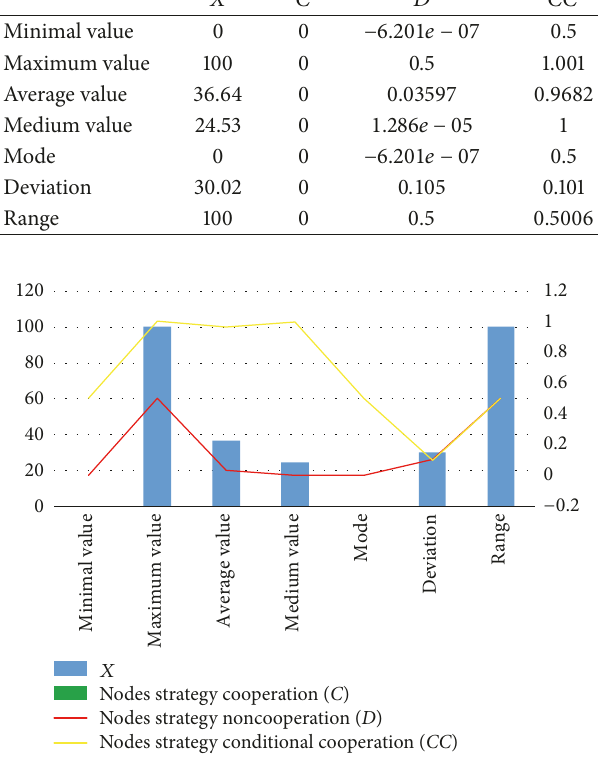
Figure 11: The state of population when 𝑋 = (0, 100, 36.64, 24.53, 0, 30.0, 100).